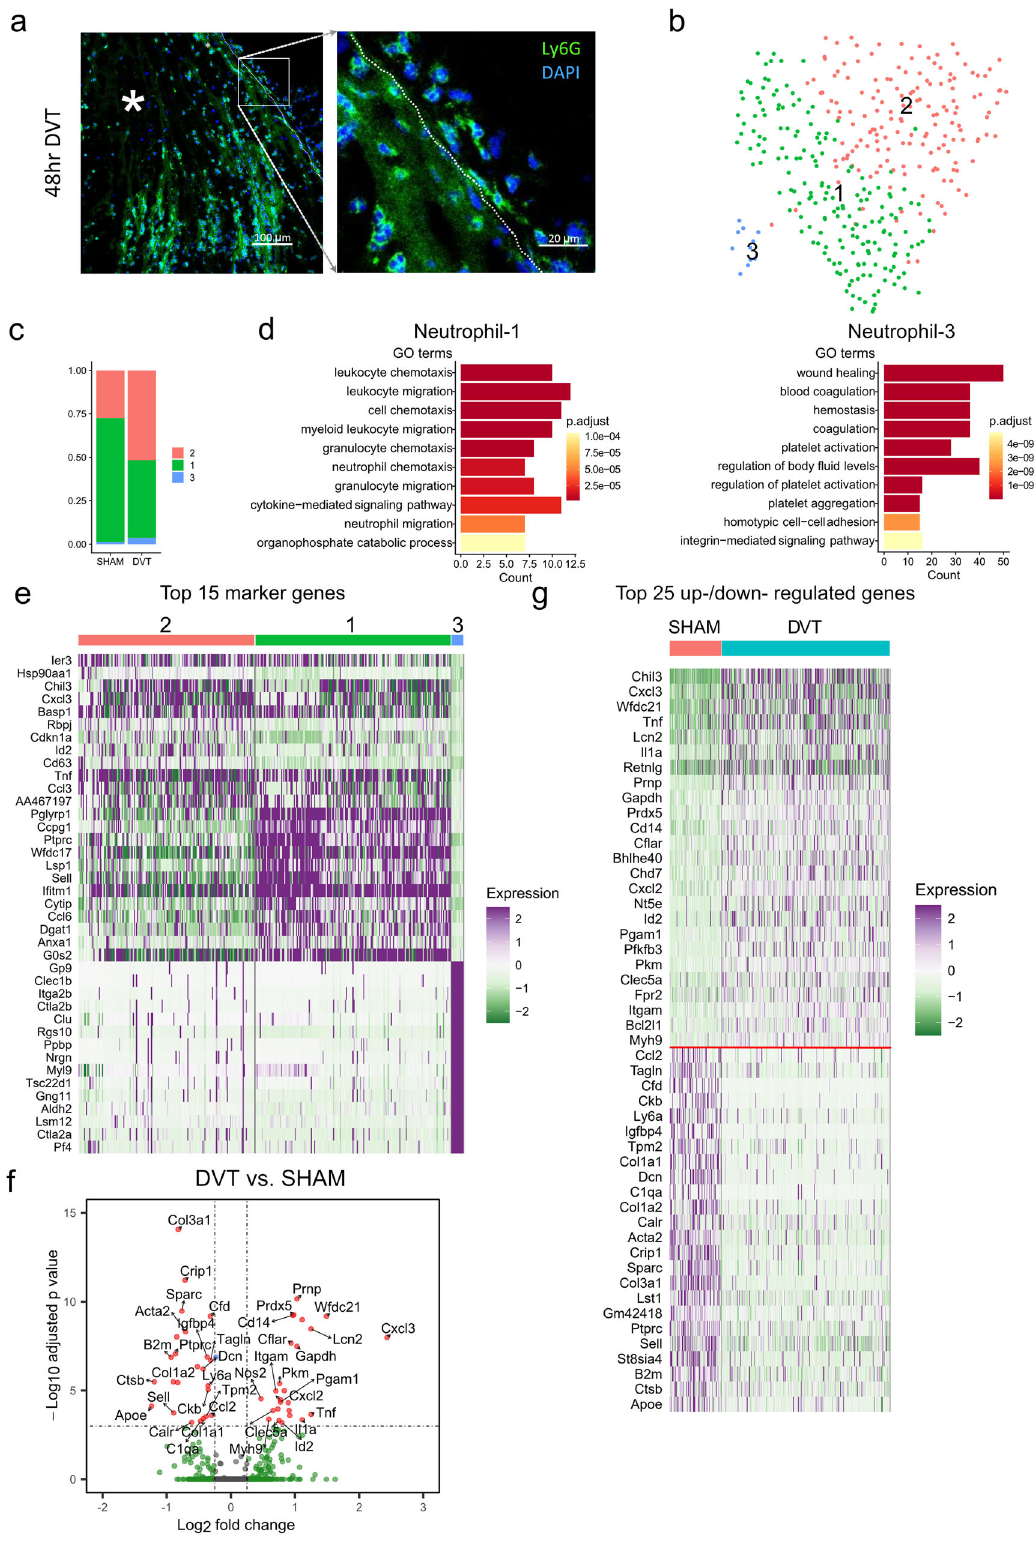
Fig. 4 Gene expression heterogeneity of neutrophils. a Immunostaining of neutrophil marker Ly6G within IVC/thrombus cross-sections 48 h after IVC ligation (left panel). DAPI was used to stain nuclei. Thrombus depicted with asterisk. Vein wall/thrombus interface highlighted by white dotted line. Area encompassed by white box shown magni fi ed in right panel. N = 3 mice for each group. b UMAP plot of sub-populations in neutrophils of sham and DVT data combined. c Relative distribution of sub-populations in sham and DVT groups. d GO analysis of Neutrophil-1 or Neutrophil-3 in comparison to the other two sub-populations. e Heatmap of the top 15 enriched genes in each sub-population in comparison to the other two sub-populations. f Volcano plot of DEGs in total neutrophils (DVT vs sham group). g Heatmap of the top 25 up- and downregulated genes in DVT compared to sham group. Up- and downregulated genes were separate by a red